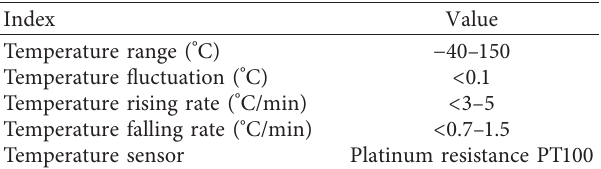
Table 2: Ambient temperature test chamber parameter perfor- mance